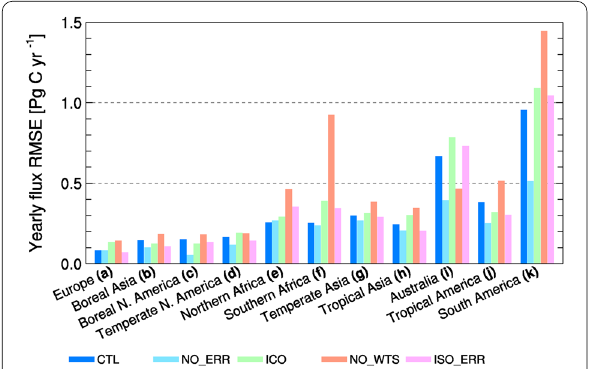
Fig. 11 Same as Fig. 10, but for the TransCom ocean